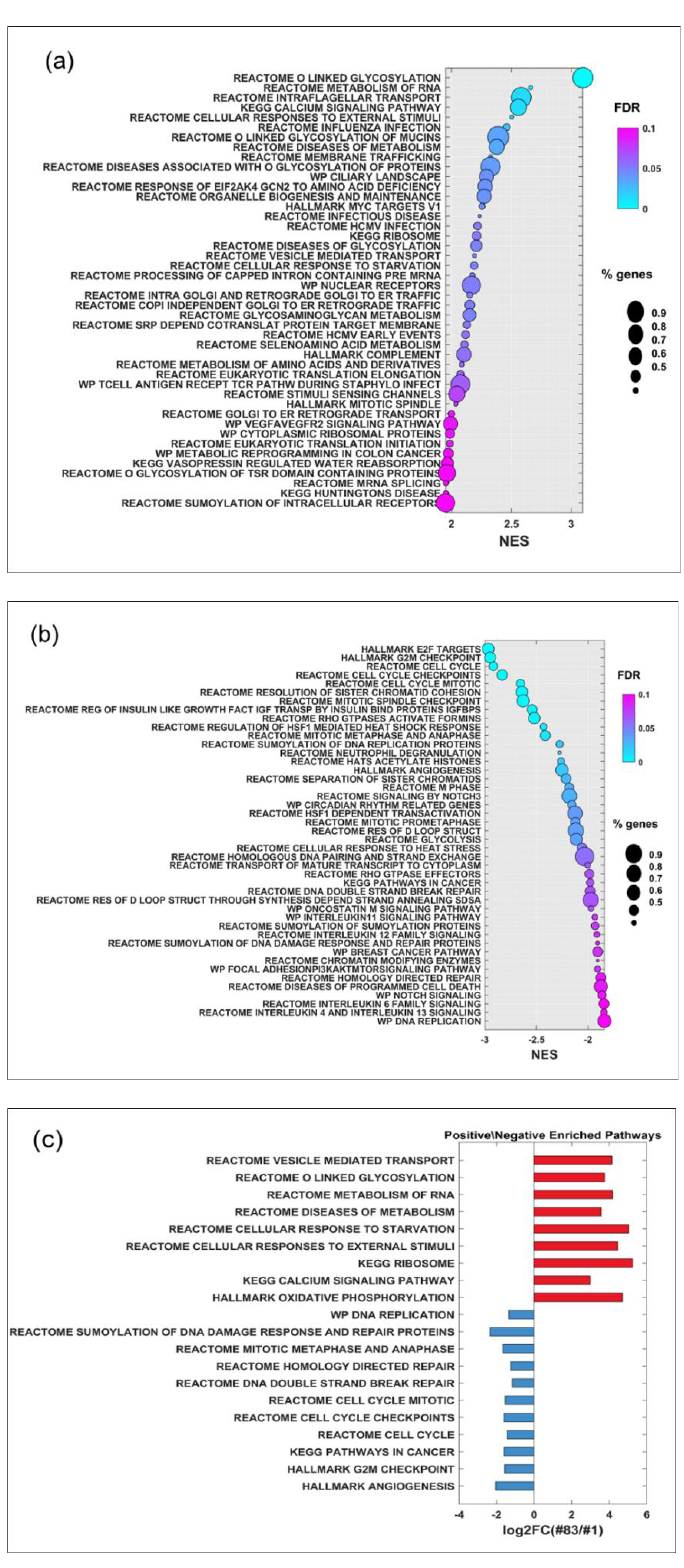
Figure 4. ( a ) Positive and ( b ) negative enrichment pathways of line #83 versus line #1 sorted using the FC of each gene. ( c ) A subset of positive in red and negative in blues enrichment pathways of line #83 versus line #1 potentially related to the radiation-induced effects. The average expression of the genes included in each pathway was evaluated to assess FC between the two